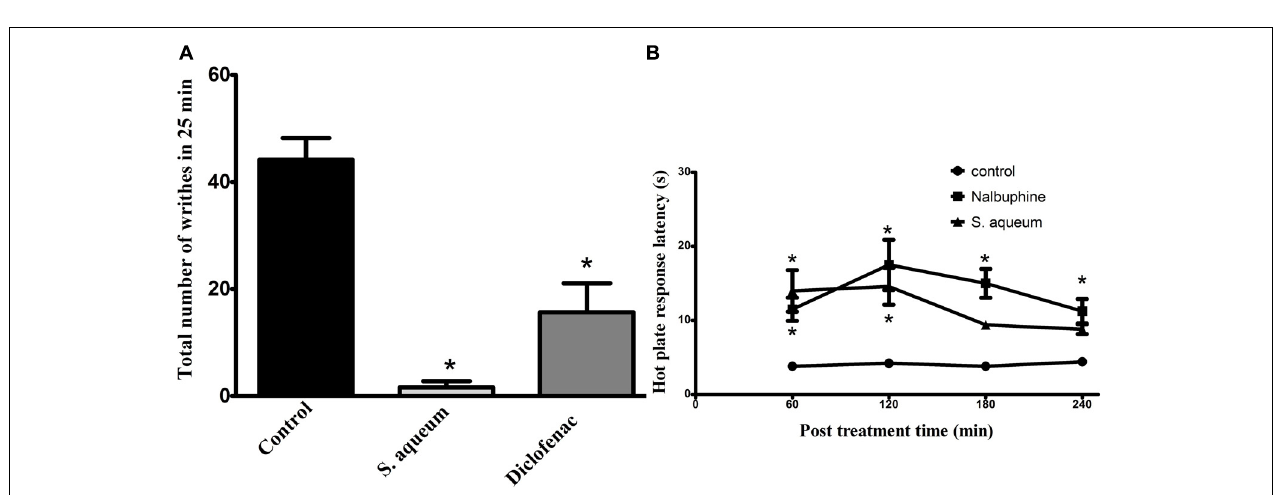
FIGURE 7 | Antinociceptive activities of S. aqueum leaf extract. (A) Effect of S. aqueum extract (300 mg/kg, p.o.) or diclofenac (10 mg/kg, p.o.) on acetic acid-induced writhing (0.7%, 1 mL/100 g) in mice. (B) Hot plate response latency measured 1–4 h after vehicle, extract (300 mg/kg, p.o.) or nalbuphine (10 mg/kg, p.o.) administration in mice. Data is expressed as mean ± SEM ( n = 5–7). ∗ p < 0.001 vs. control